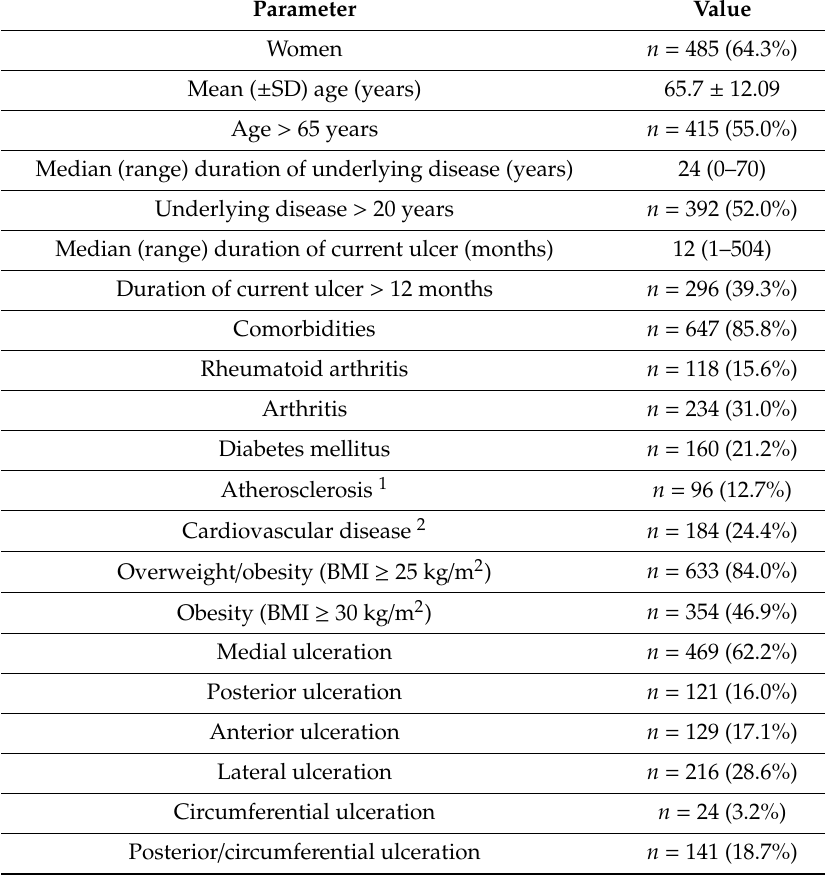
Table 1. Characteristics of the study group included in the